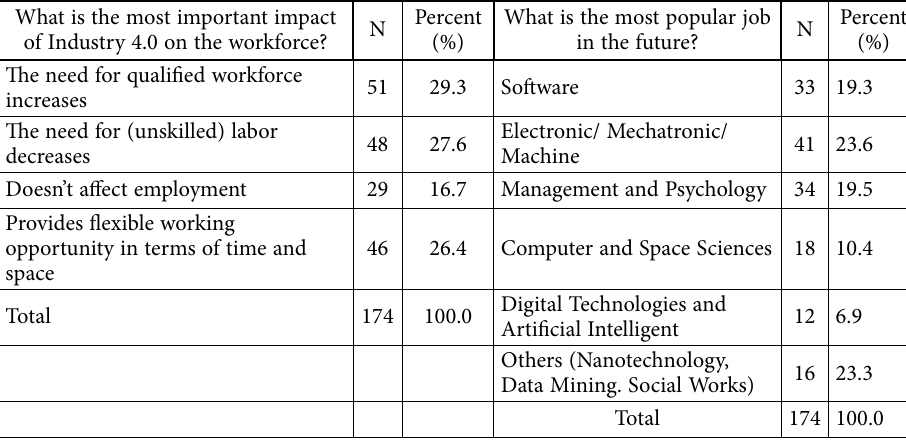
Table 5. The future perceptions of the respondents What is the most important impact of Industry 4.0 on the